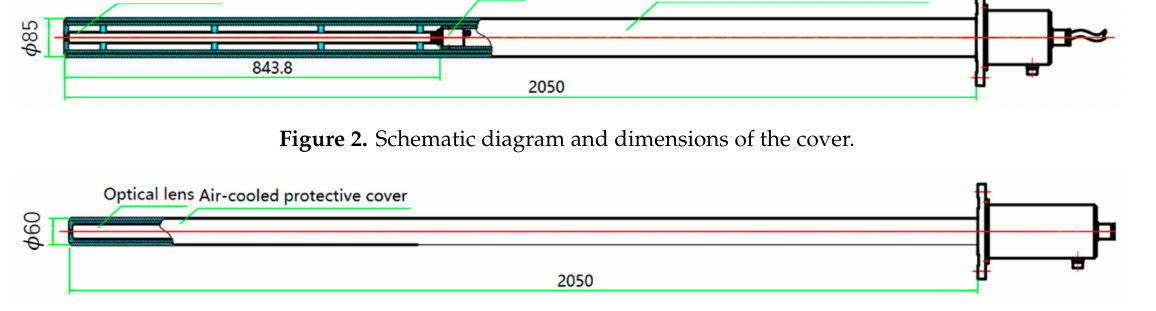
Figure 3. Schematic diagram and dimensions of the internal